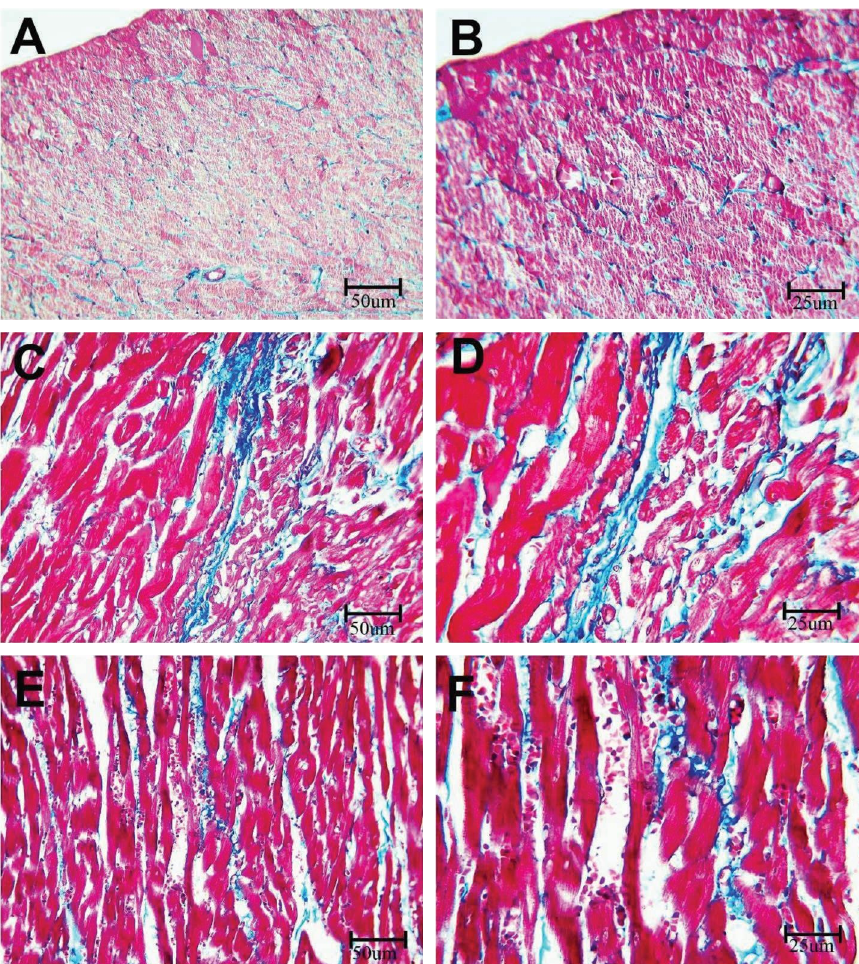
Figure 4: Histopathological section in the heart of rat stained with Masson trichrome stain. a and b is the control group, c and d are the BPA group, and e and f are the BPA +LC group. Te myocardium of the control group shows minimal bluish-stained collagen fbers. Te expression of the color is notably increased in the BPA group and reduced in the BPA +LC group (Masson trichrome stain; A, C, and E X 200, B, D, and F X 400).